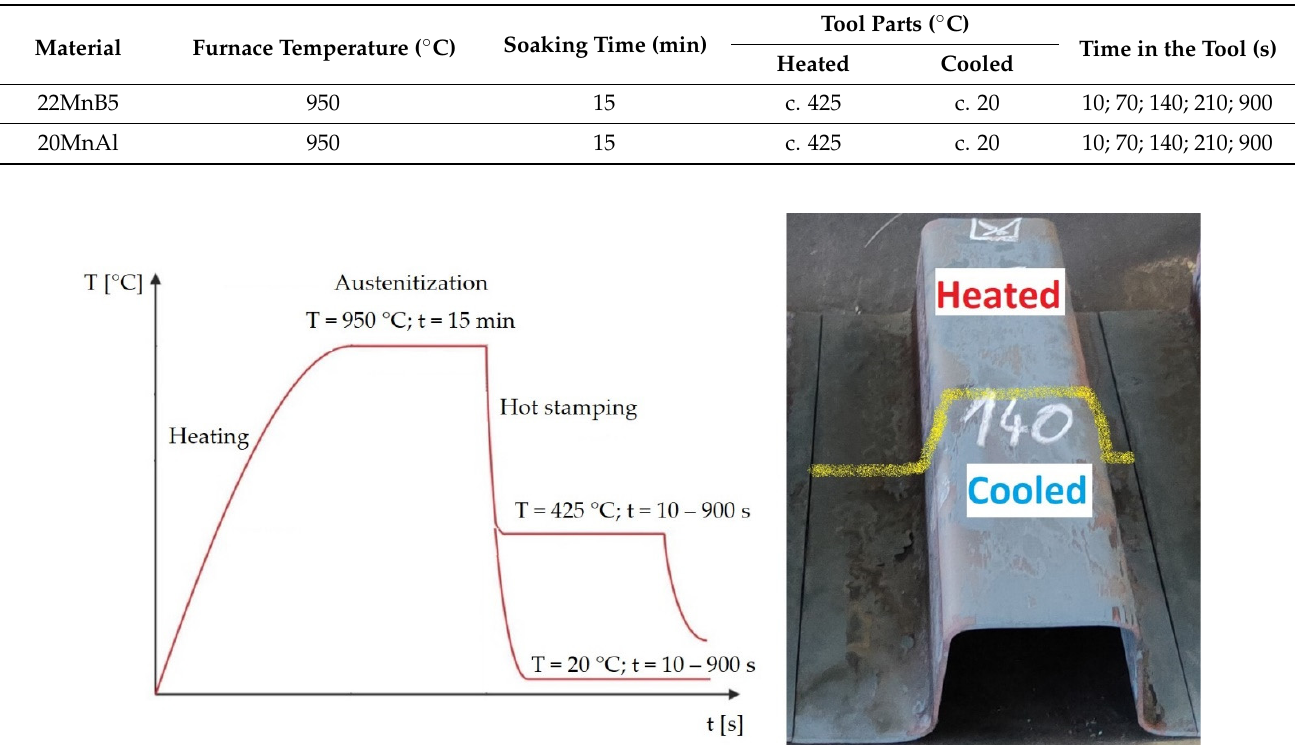
Table 2. Parameters of experimental programme.